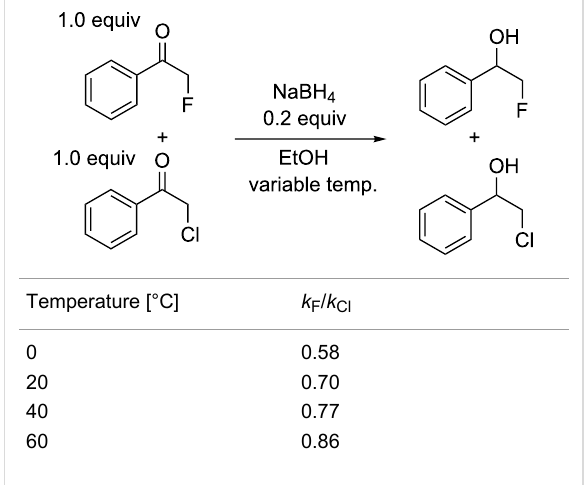
Table 1: Relative reactivity of α -fluoroacetophenone and α -chloro- acetophenone at different temperatures.